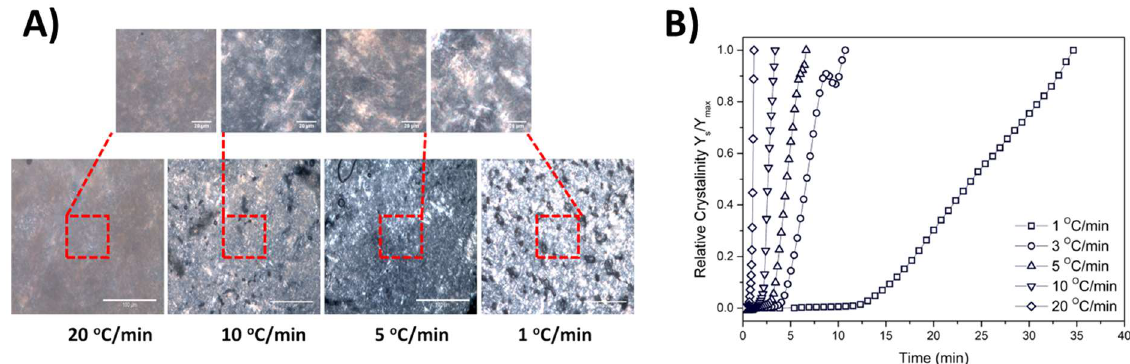
Figure 3. Typical example of relative crystallinity (quantified by rheology data) plotted as a function of time for the 20 GMS/5 GMO sample at cooling rates from 1 to 20 °C/min (A), alongside the respective polarized micrograph obtained at the end of each measurement, at two different magnifications (red square area is magnified at the respective micrograph) (B).